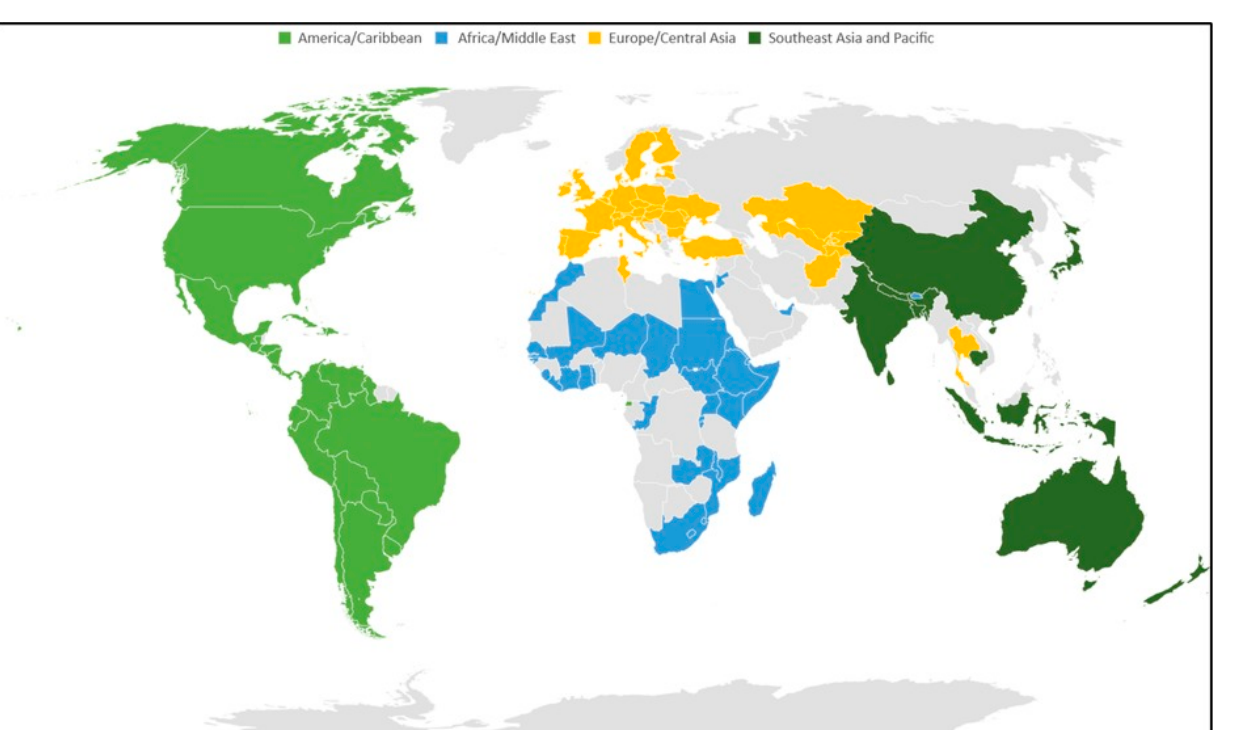
Figure 2. Distribution of school-based feeding programs by regions and their respective countries. America/Caribbean ( n = 28; 23.91%): Argentina, Bahamas, Barbados, Bolívia, Brazil, Canada, Chile, Colombia, Costa Rica, Cuba, Dominica, Dominican Republic, Ecuador, El Salvador, Equatorial Guinea, Guatemala, Guyana, Haiti, Honduras, Mexico, Nicaragua, Panama, Paraguay, Peru, Trinidad and Tobago, USA, Uruguay, and Venezuela. Africa/Middle East ( n = 38; 32.5%): Bhutan, Burkina, Burundi, Faso, Cape Verde, Chad, Congo, Côte d`Ívoire, Djibouti, Egypt, Eritrea, Essuatíni, Ethiopia, Gambia, Ghana, Guinea Bissau, Jordan, Kenya, Lesotho, Liberia, Madagascar, Malawi, Mali, Morocco, Mozambique, Republic of Niger, Rwanda, São Tomé and Príncipe, Senegal, Sierra Leone, Somalia, South Africa, South Sudan, Sudan, Togo, Uganda, United Arab Emirates, and Zambia. Europe/Central Asia ( n = 41; 35%): Afghanistan, Albania, Andorra, Armenia, Austria, Azerbaijan, Belgium, Bulgaria, Croatia, Cyprus, Czech Republic, Denmark, Estonia, Finland, France, Germany, Hungary, Ireland, Italy, Kazakhstan, Kyrgyzstan, Latvia, Luxembourg, Netherlands, Macedonia, Poland, Portugal, Moldova, Romania, Slovakia, Slovenia, Spain, Sweden, Switzerland, Tajikistan, Thailand, Tunisia, Turkey, Ukraine, United Kingdom, and Uzbekistan. Southeast Asia/Pacific ( n = 11; 9.4%): Australia, Bangladesh, Cambodia, China, India, Indonesia, Japan, Nepal, New Zealand, Sri Lanka, and East Timor.